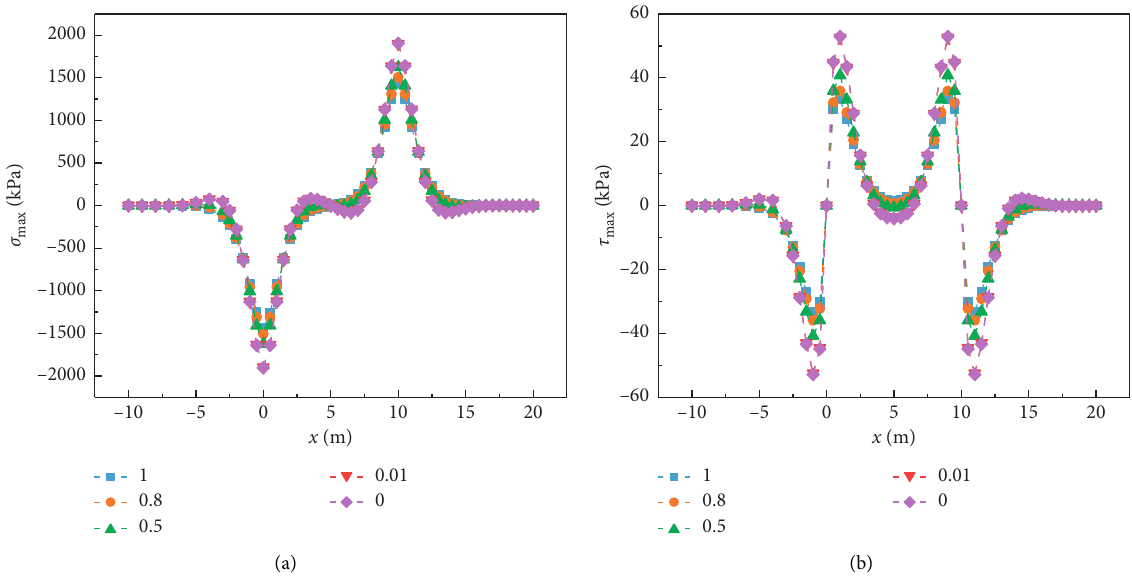
Figure 6: Distribution situation of maximum normal stress (a) and maximum shear stress (b) of bottom lining at different R values.